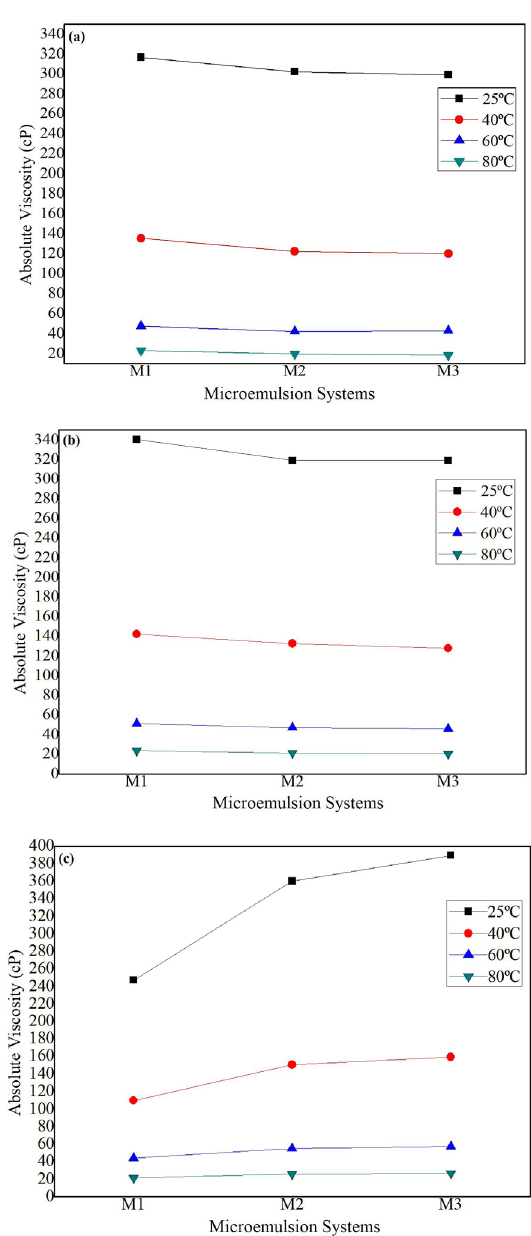
Figure 5. Absolute viscosity versus surfactant concentration: (a) NP4EO, (b) NP6EO and (c) NP9.5EO.